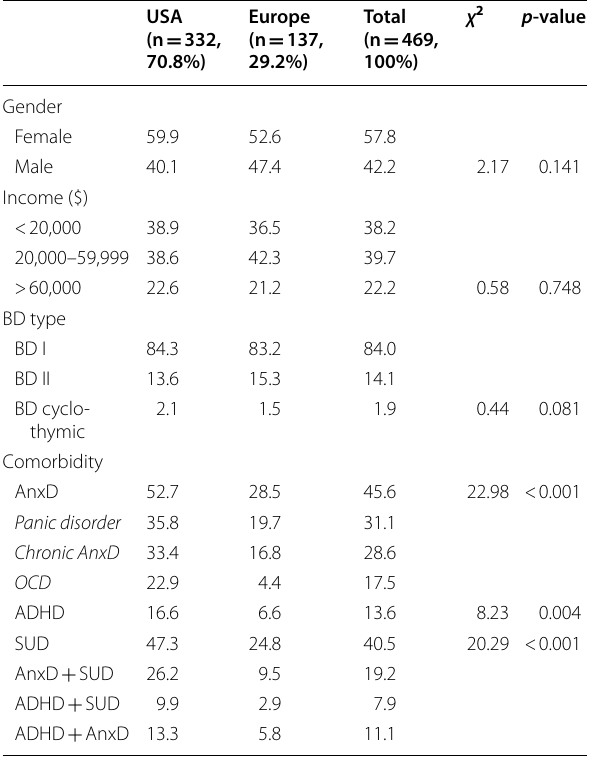
Table 1 Demographic characteristics and comorbidity